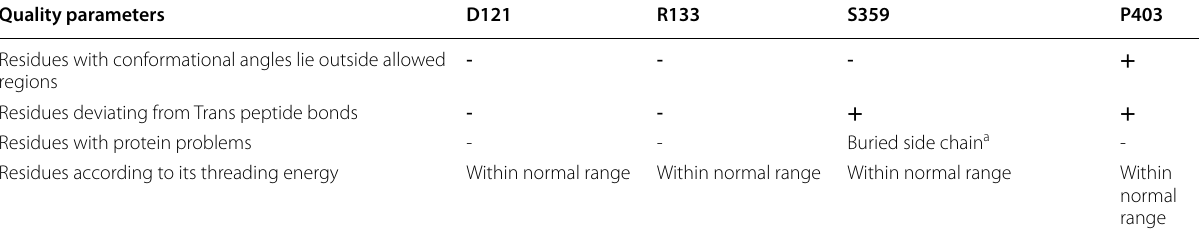
(‑) means score lies in allowed range, but ( a Residues that could make H bonds but do not